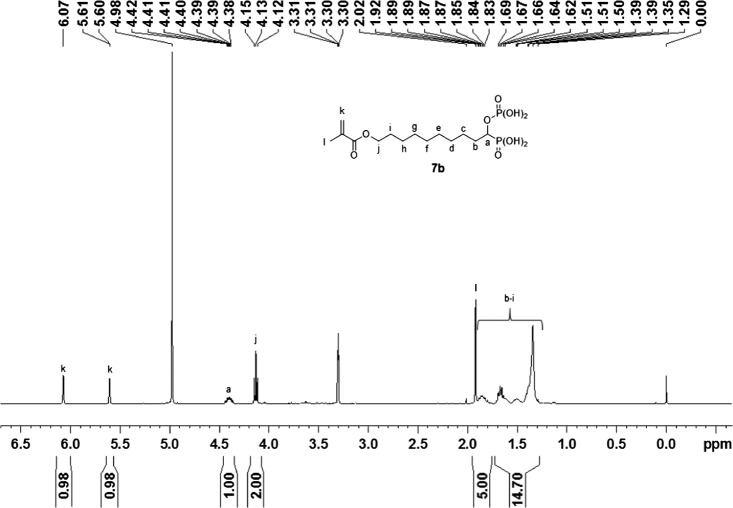

1H-NMR spectrum of monomer 7b.